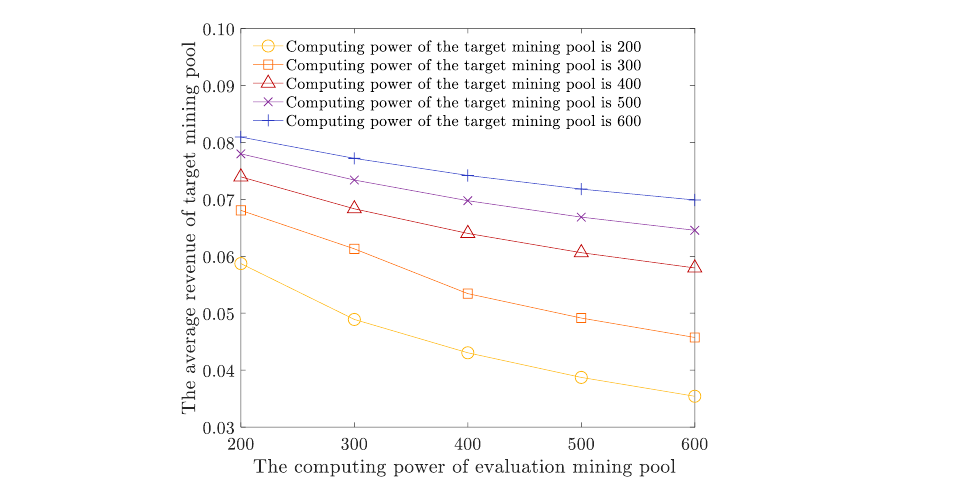
Figure 7. Average revenue of evaluation mining pools and target mining pools with different computing power.